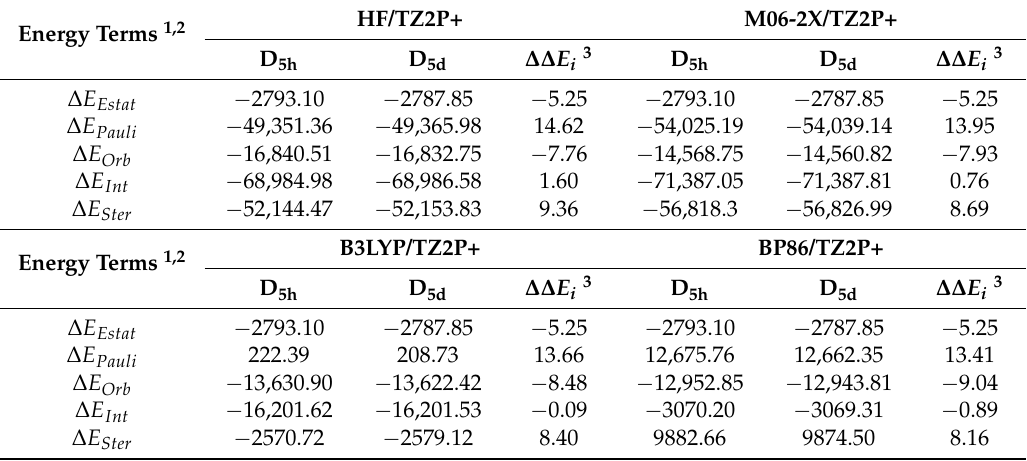
Table 3. Comparison of energy terms for the eclipsed (D 5h ) and staggered (D 5d ) ferrocene